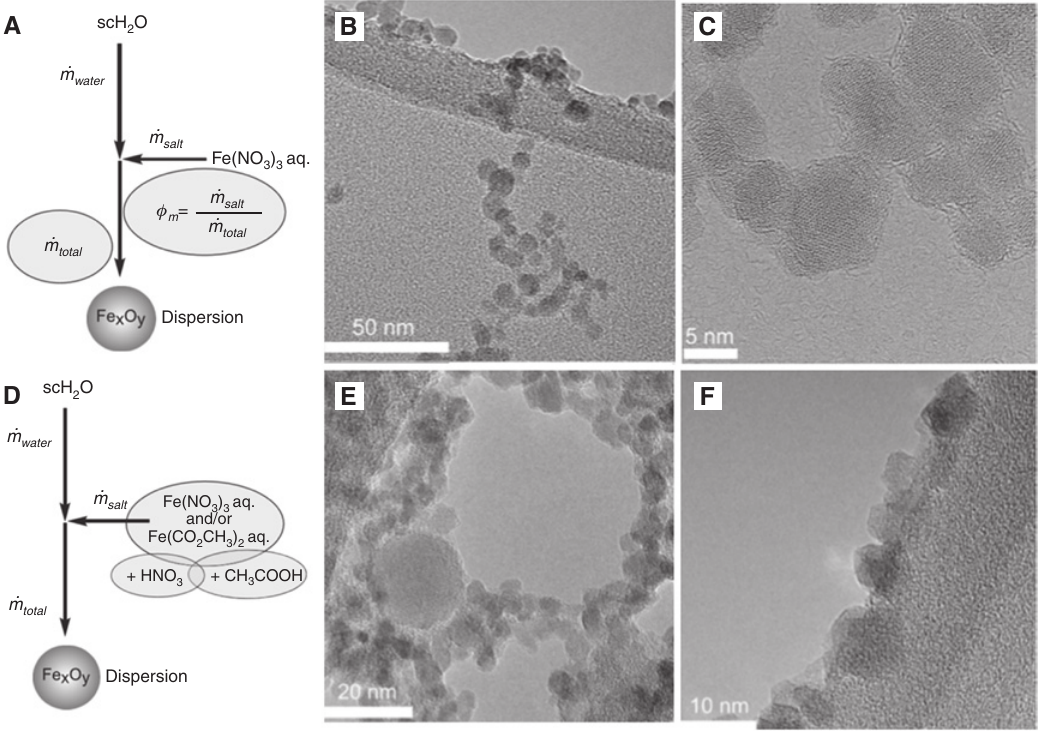
Figure 21: Iron oxide synthesized at different conditions (reprinted with permission from Daschner de Tercero M, Röder C, Fehrenbacher U, Teipel U, Türk M, J. Nanopart. Res. 2014, 16, 2350-1–2350-27 [103], Copyright 2014 Springer): mixing ratio, fluid velocity (A) at 3 kg/h (B) and 9 kg/h (C): different chemical compositions (D): mixture at 3 kg/h (E) and 6 kg/h (F).